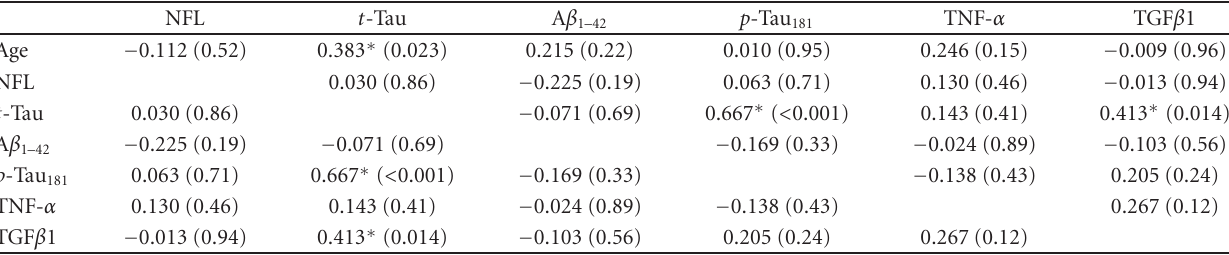
Table 4: Correlations between CSF